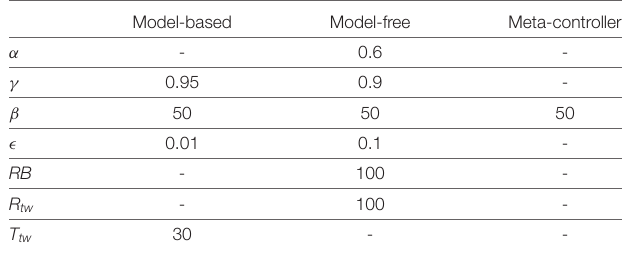
TABLE 3 | Parameters used to generate the results in this section.